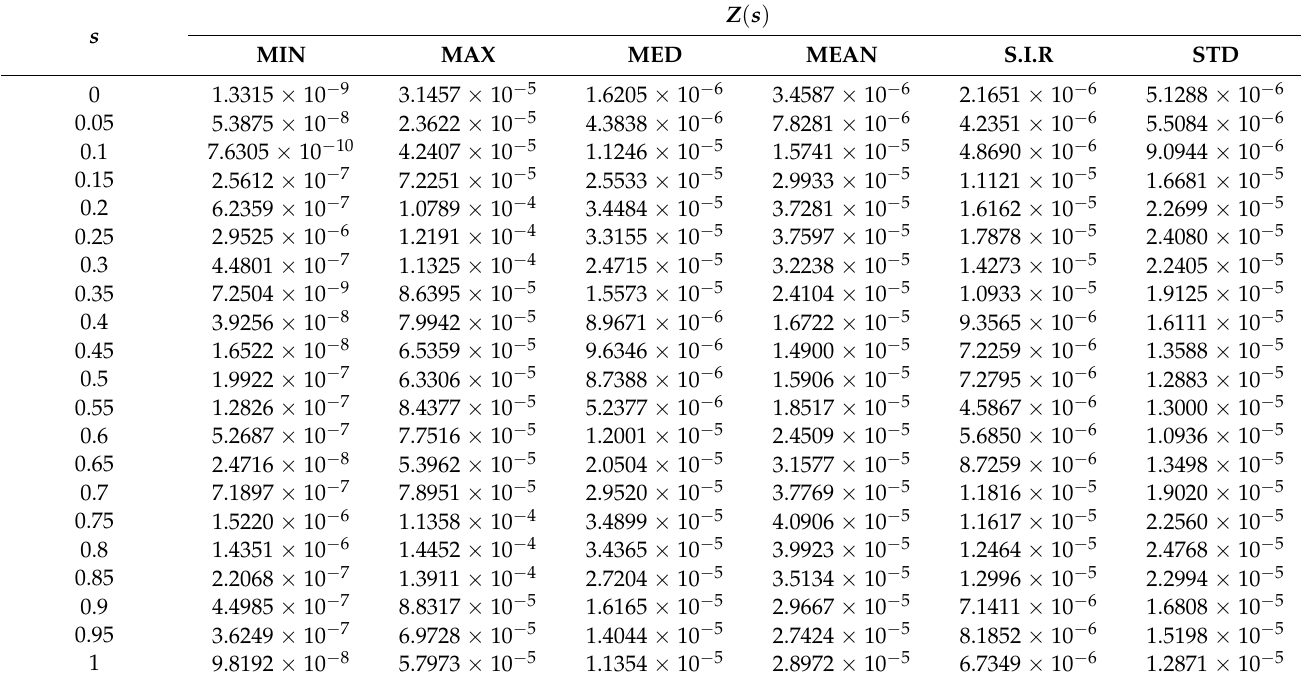
Table 4. Statistical presentations of the environmental and economic nonlinear model for Z ( s ) .